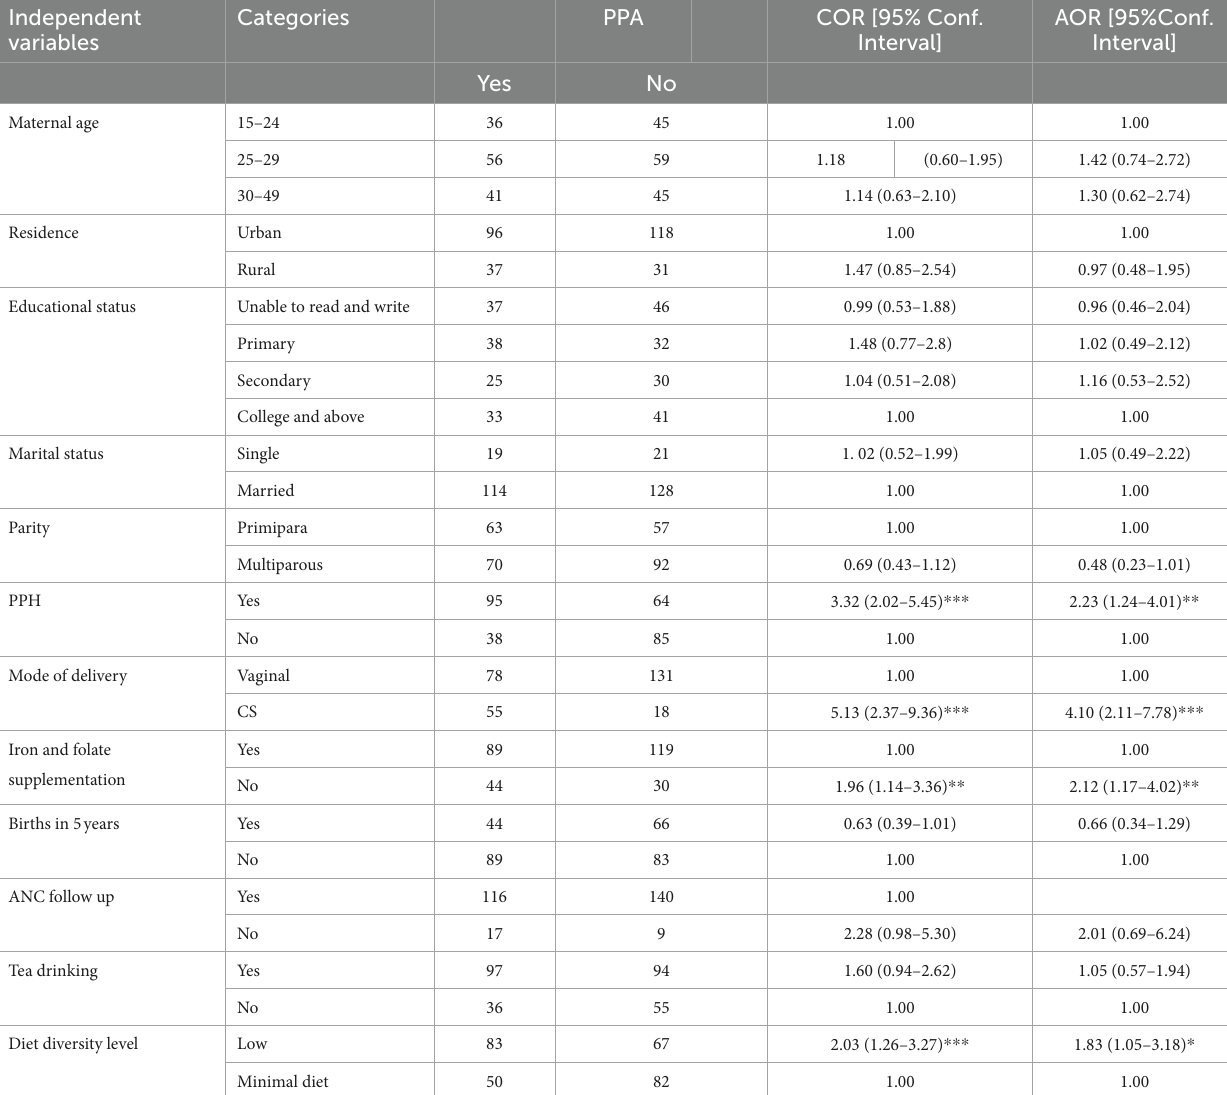
TABLE 5 Logistic regression showing factors associated with PPA in Gondar town, Northwest Ethiopia, 2021 ( n = 282). Independent